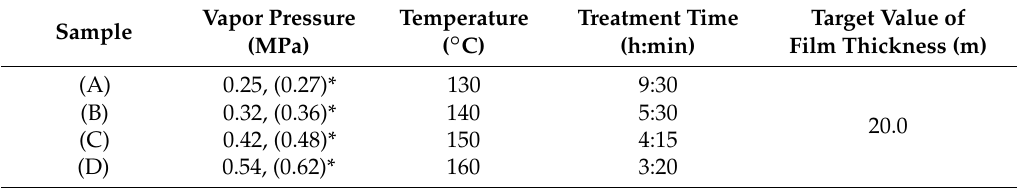
Figure 1. Schematic illustration of experimental set-up for steam coating. Table 1. Treatment conditions for steam coating of all samples on AZ61.